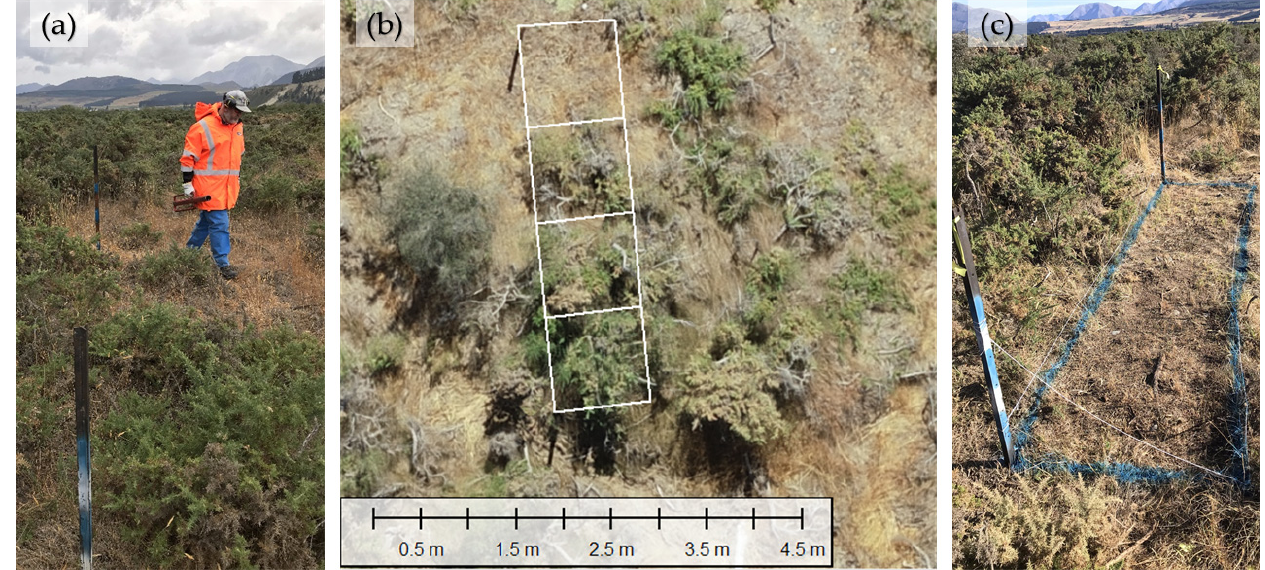
Figure 2. ( a ) Field plot establishment; ( b ) digitised 4 × 1 m quadrat, showing the layout of the four 1 × 1 m sub-plots used for non-destructive sampling; ( c ) field plot after destructive sampling, showing the painted outline used for annotation in the GIS.